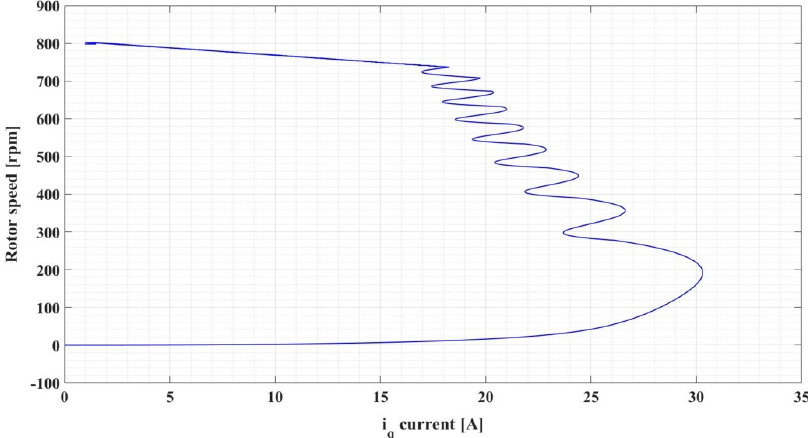
Figure 17. Image of the phase plan for PMSM variable structure with switching signal type 1: rotor speed versus i q current.